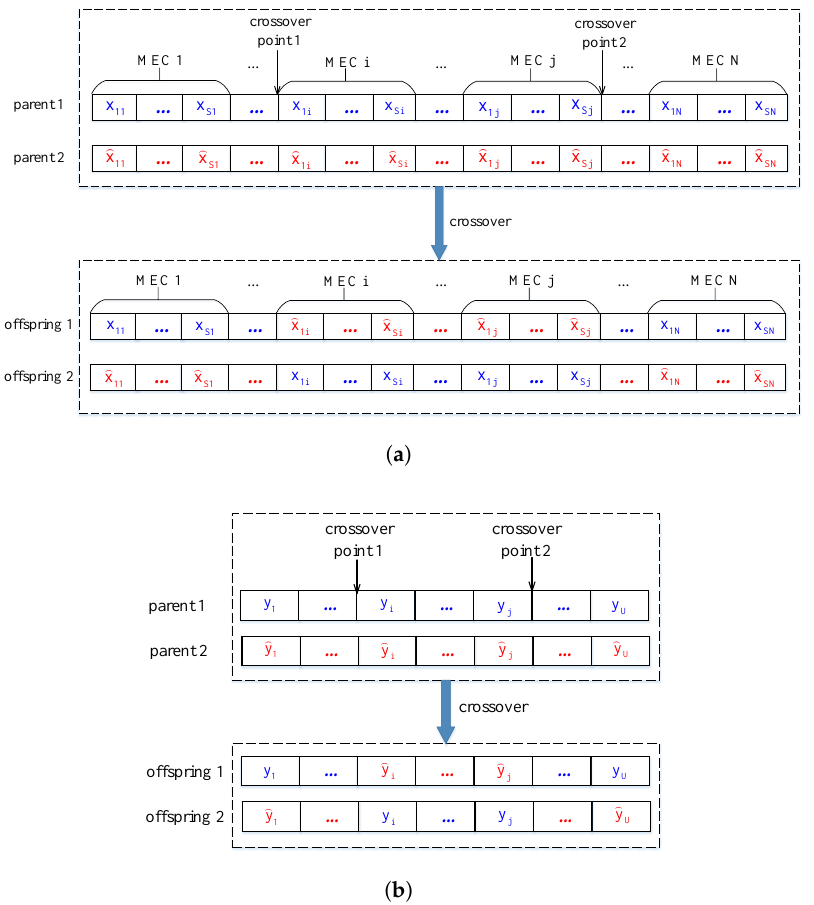
Figure 5. Two-point crossover. ( a ) Service placement individuals; ( b ) Request scheduling